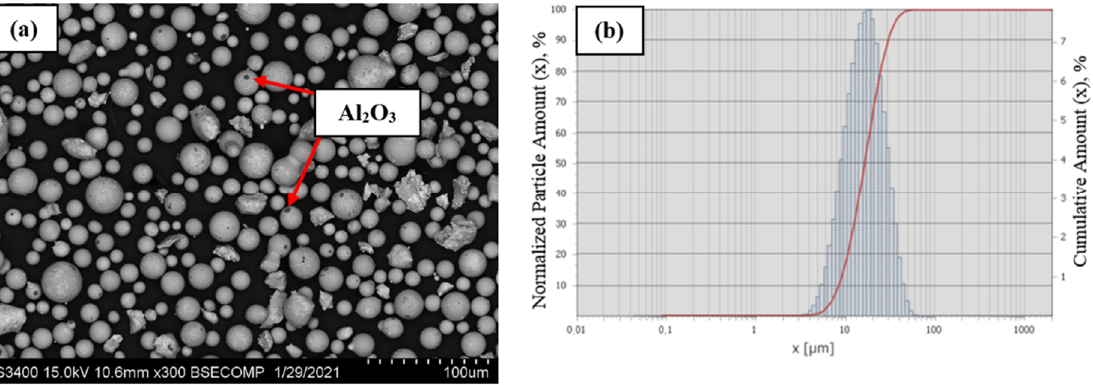
Figure 20. The morphology ( a ) and granulometric composition ( b ) of the NiAl–Cr–Co+15%Mo alloy powder at I pl = 1.71 kW h/m 3 , G powder = 3 kg/h, with Ar used as a plasma supporting gas.